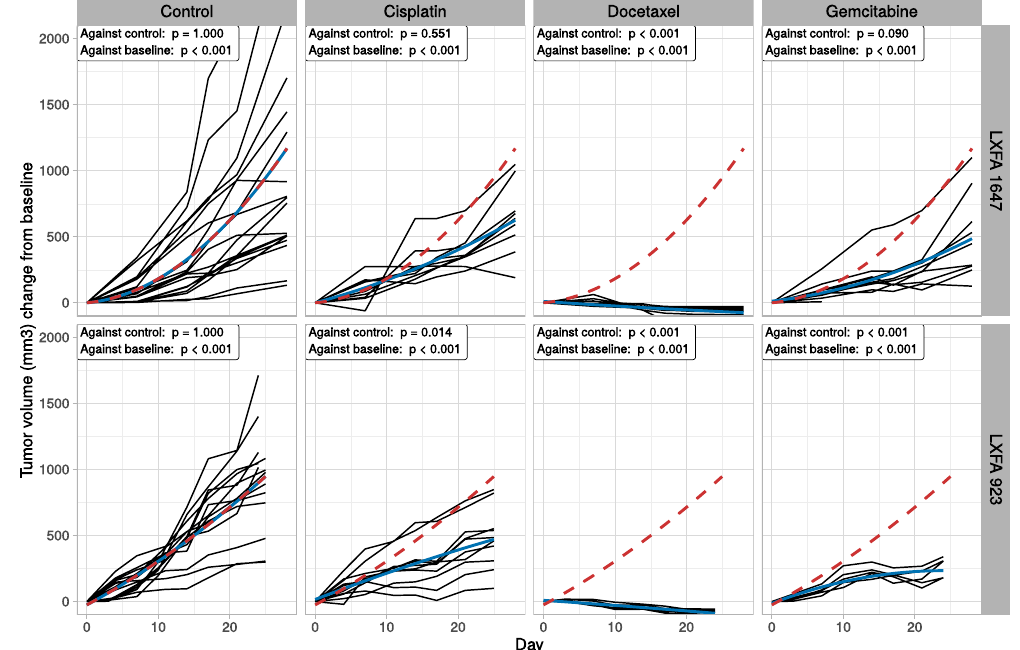
Figure 9. Drug sensitivity tests in PDX models. Two PDX models, LXFA 1647 and LXFA 923, were treated with standard-of-care drugs, cisplatin (5 mg / kg / day for LXFA923 and 8 mg / kg / day for LXFA 1647), docetaxel (150 mg / kg / day ) and gemcitabine (200 mg / kg / day ). Each black line represents repeated measurements of tumor volume from an individual mouse, blue solid line the treatment average and red dashed line the control average. The average fits are obtained with a simple second degree polynomial. Two statistical tests are performed: one against the control treatment and one against the baseline. The statistical tests were performed using robust and non-parametric methods for repeated measurements 62 . These methods are less vulnerable to the heterogeneous variance and variable trends of the growth curves compared to conventionally used parametric